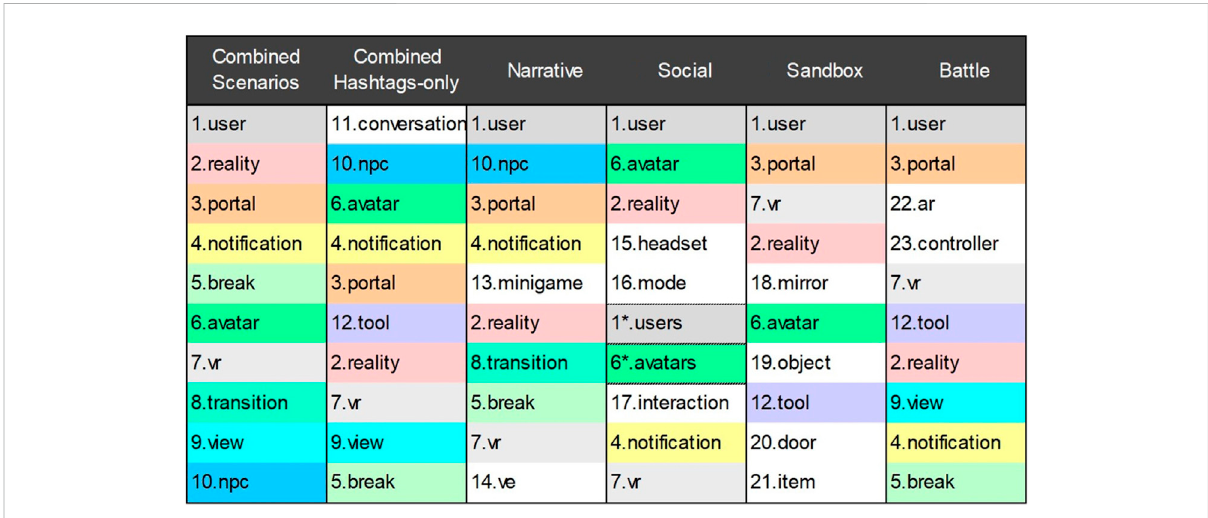
FIGURE 1 Keywords extracted by the semantic folding algorithm. The 1 st column extracted from all the data from every scenarios combined. The 2 nd columnonlyconsideredtheexplicithashtagskeywords.The3 rd tothe6 th columnextractedkeywordsforthecombineddataforeachscenario.Each unique keyword has been numbered and colour-coded for